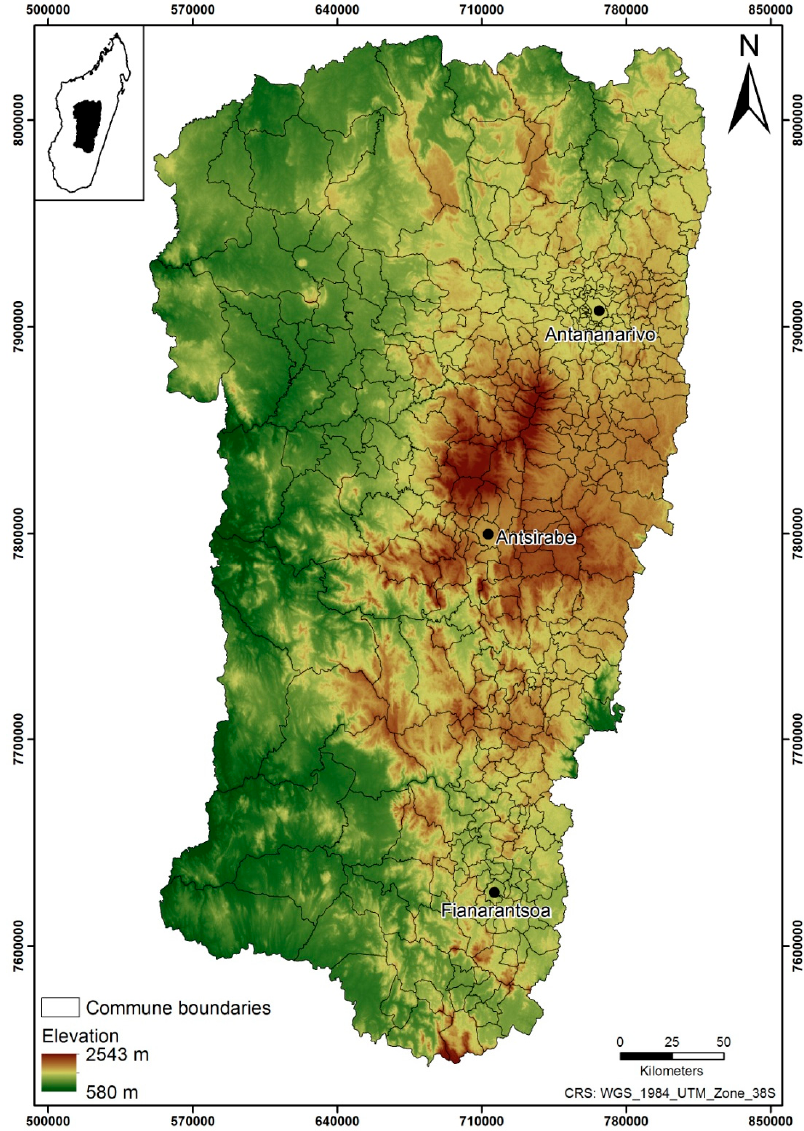
Figure 1. Central highlands (CHL) of Madagascar.